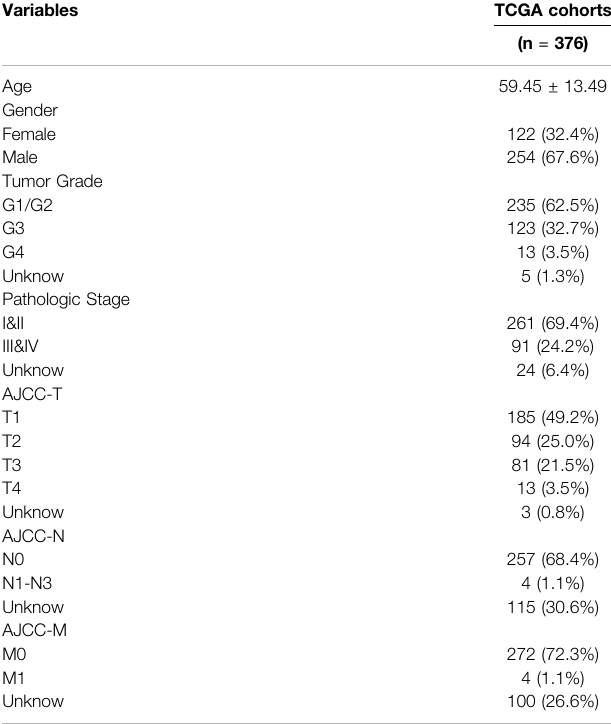
TABLE 1 | Basic clinical information of all 376 HCC patients from TCGA